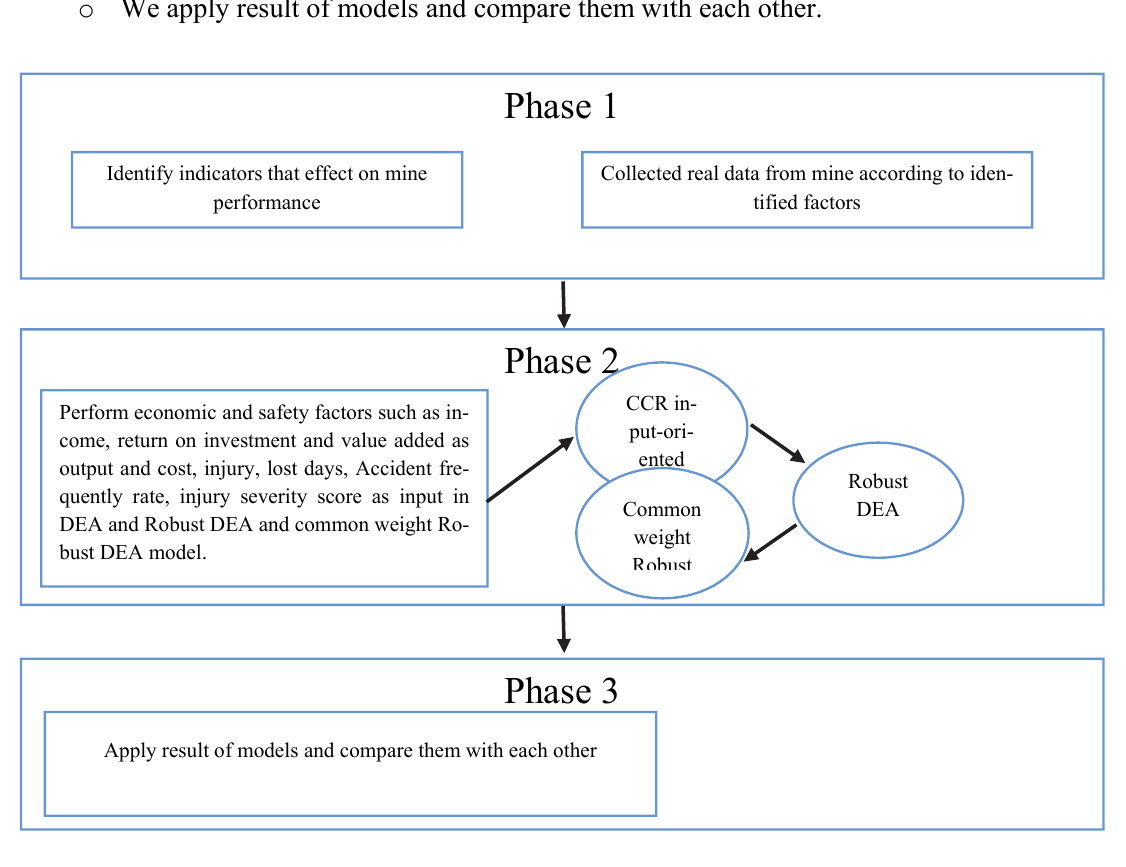
Fig. 1. Flowchart of the proposed